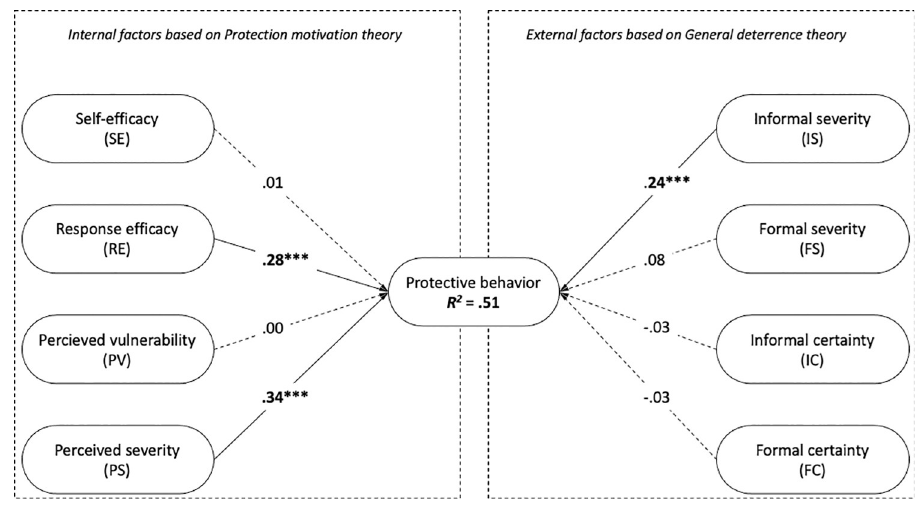
Fig 2. Model test results ( � — p < .05; ��� — p <